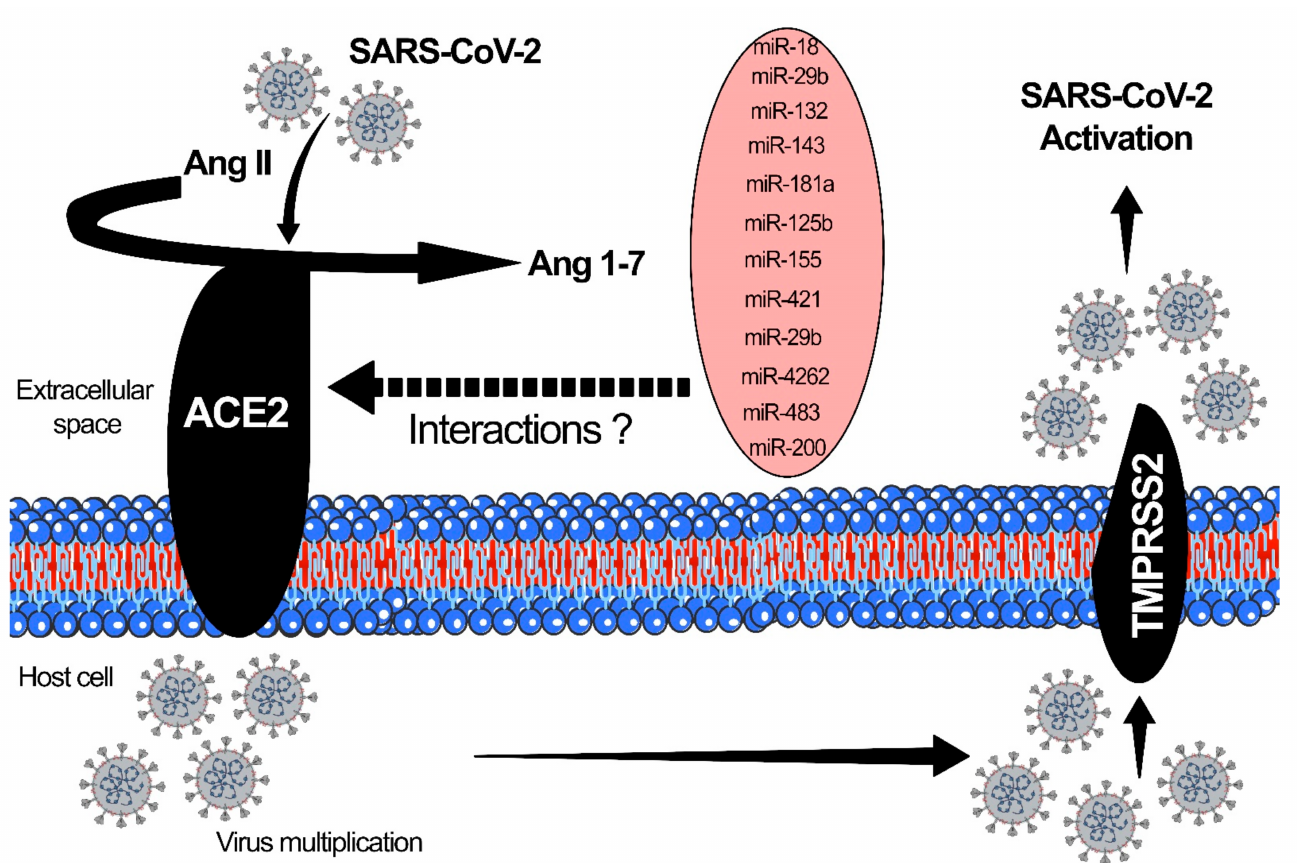
Figure 3. ACE2-related